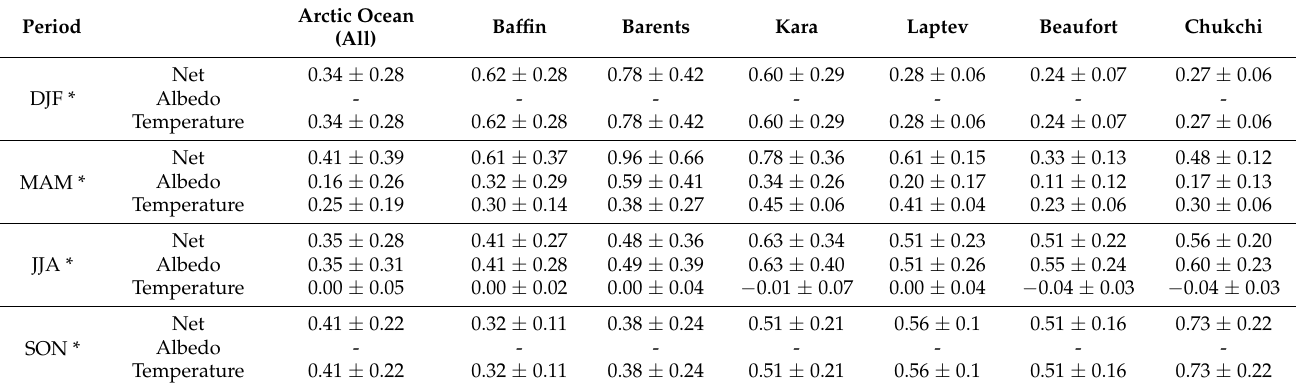
Table 3. SIRFs seasonal change according to region (W/m 2